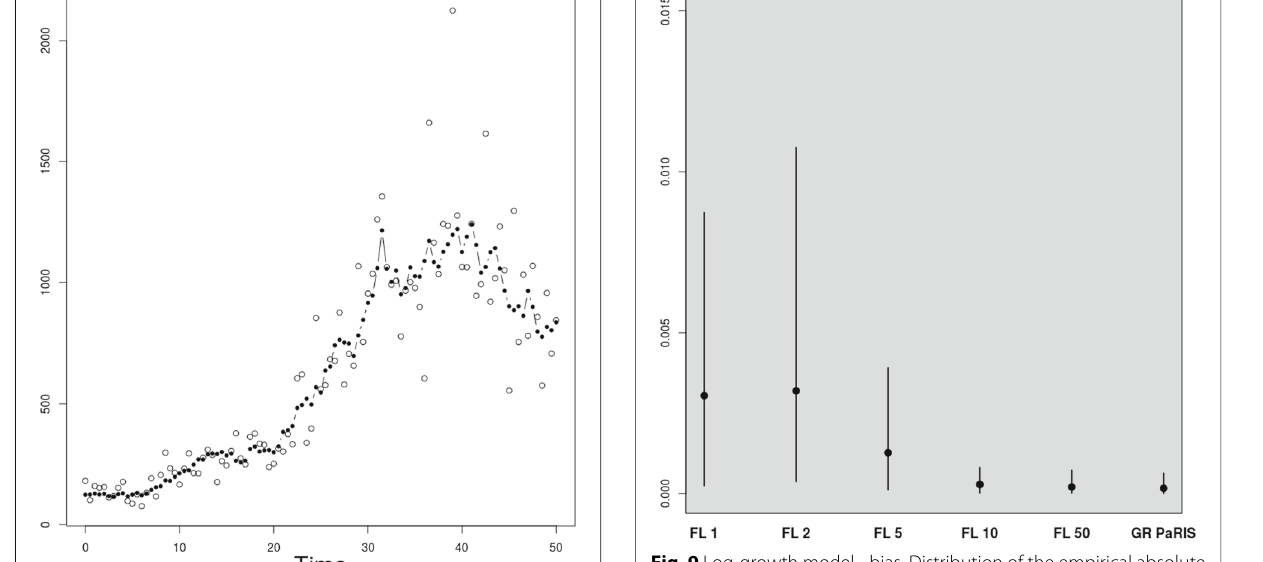
U m such that for all x ≥ m , ψ( x ) : = α 2 ( x ) + α (cid:5) ( x ) ≤